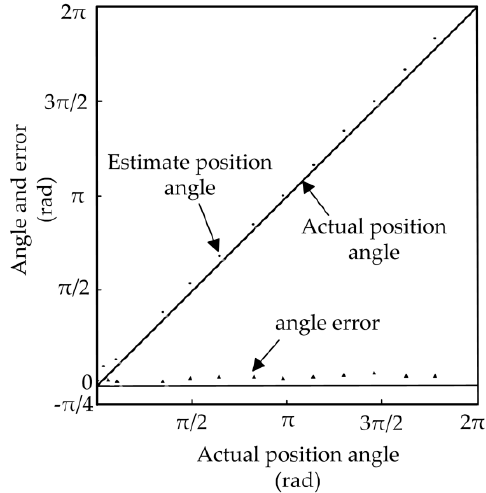
Figure 15. Comparison between actual angle and estimated angle.